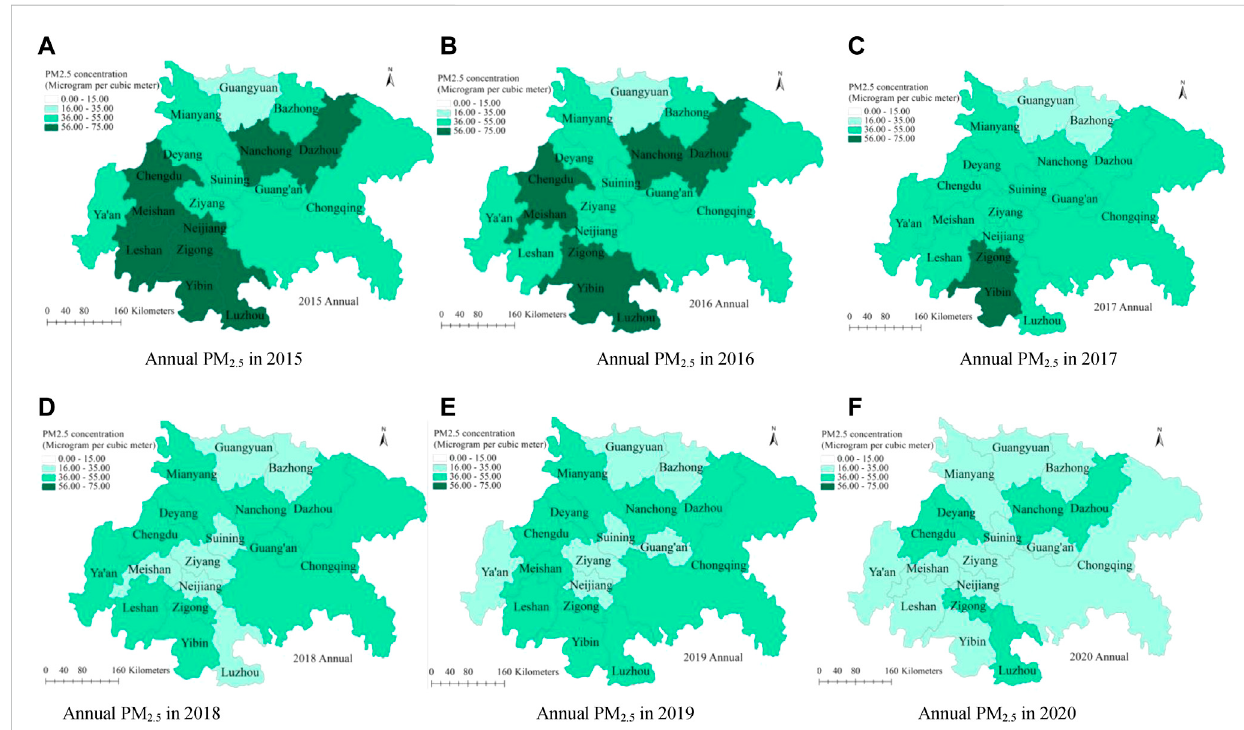
FIGURE 2 PM 2.5 annualconcentrationinSCB2015-2020. (A) AnnualPM 2.5 in2015 (B) AnnualPM 2.5 in2016 (C) AnnualPM 2.5 in2017 (D) AnnualPM 2.5 in2018 (E) Annual